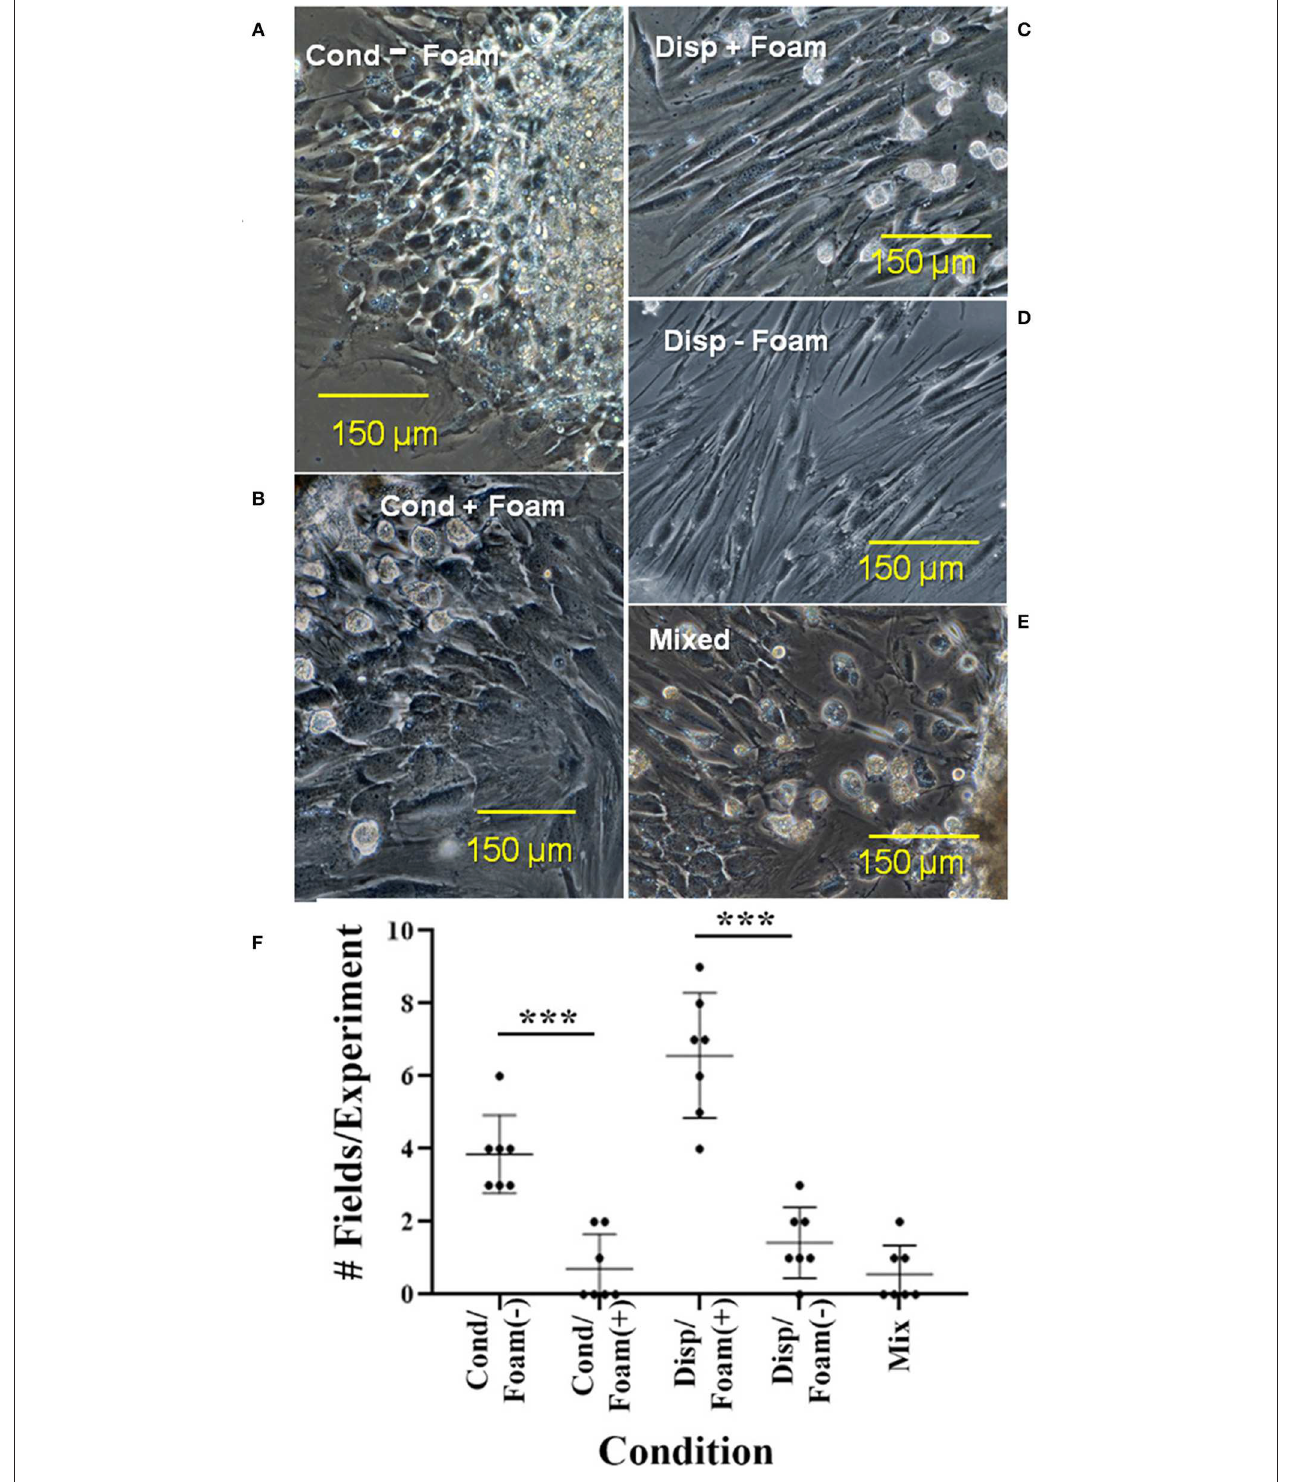
FIGURE 14 | Five types of cellular interactions between ependymal cells and foam cells in cultured regenerative outgrowth. Cultures in which foam cells were associated with condensed or dispersed ependymal cells from 14 to 17D spinal cord outgrowths were quantitated. Dispersed ependymal cells show a preference for associating with foam cells: (C) As opposed to condensed ependymal cells (A,B) or mixed condensed and dispersed ependymal cells (E) . (D) Shows a limited region of dispersed ependymal cells without foam cells. (F) Shows a graph depicting the quantitation of cultures. Cond, condensed; disp, dispersed. *** p ≤ 0.0001. Magnification bar is shown in the lower portion of each